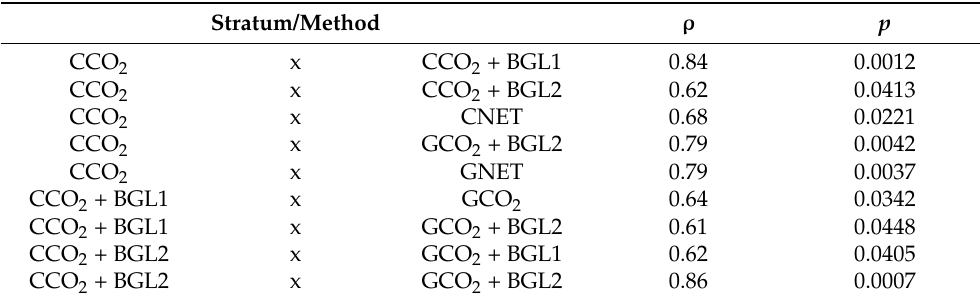
Table 3. Comparison of different capture and stratum methods (C = canopy and G = ground). Spearman correlation coefficients ( ρ ) and statistical significance values ( p ) presented for significant